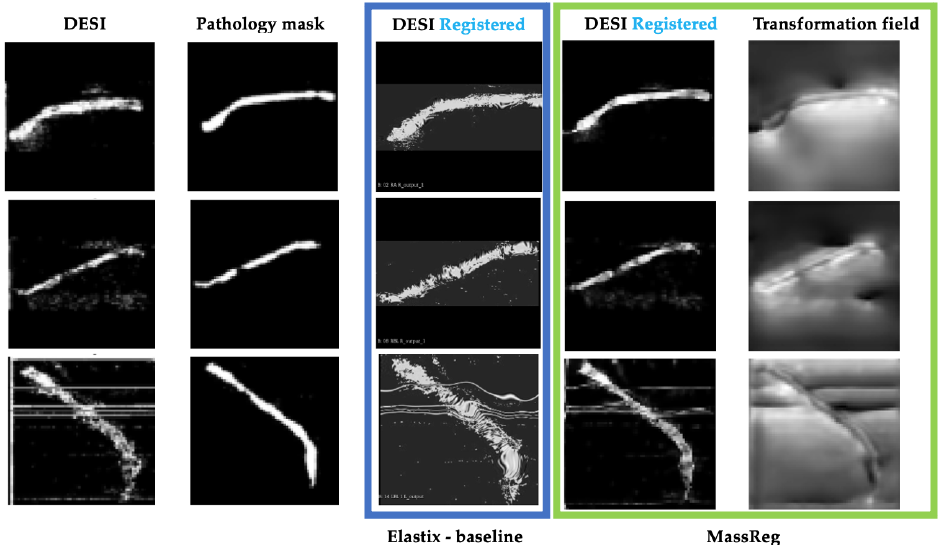
Figure 11. MassReg registration results after experiment 2 of training on real un-registered image pair. Left to right: DESI-MS images, corresponding pathology masks, registered DESI images with Elastix, registered DESI images with MassReg, transformation field from MassReg output.